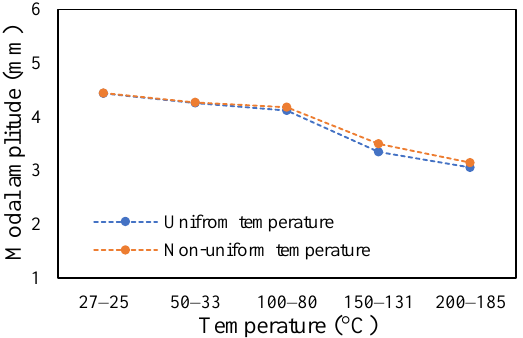
Figure 24. Comparison of modal amplitude of 0.25 mm crack depth ramped at 2 °C/min.